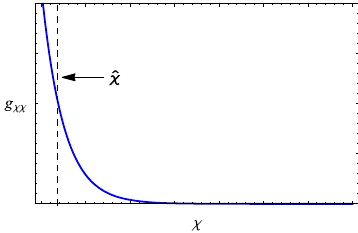
Fig. 3 Left panel: The lapse function N trend versus the χ coordinate. As can be seen, this object is completely regular at the throat χ = ˆ χ . Right panel: The behavior of the f function against the χ variable. It is observed that at the throat, f ( ˆ χ) = 0 making the metric (71) singular